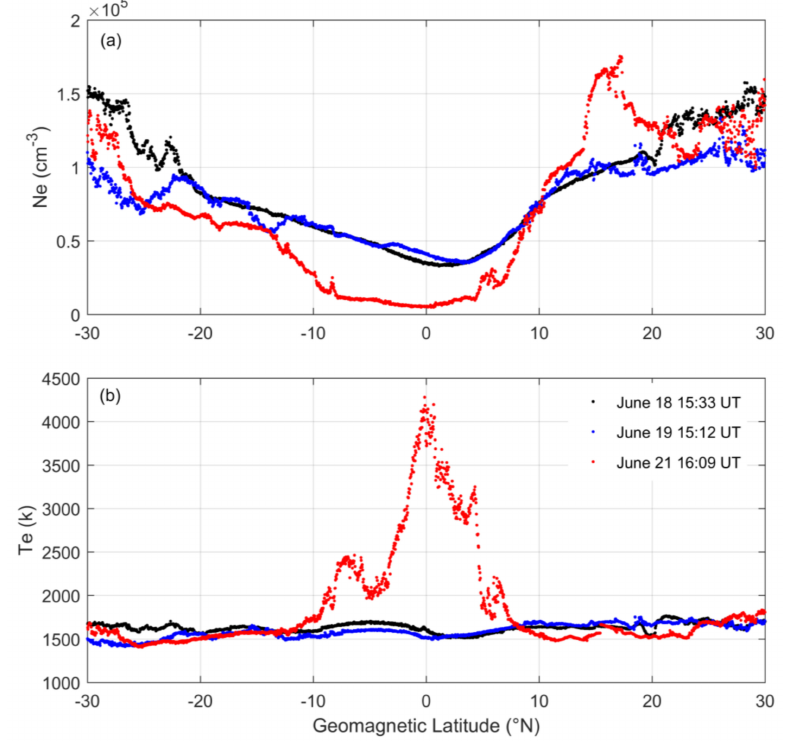
Figure 6. Swarm-B observed ( a ) N e and ( b ) T e in the nighttime on the solar eclipse day and reference